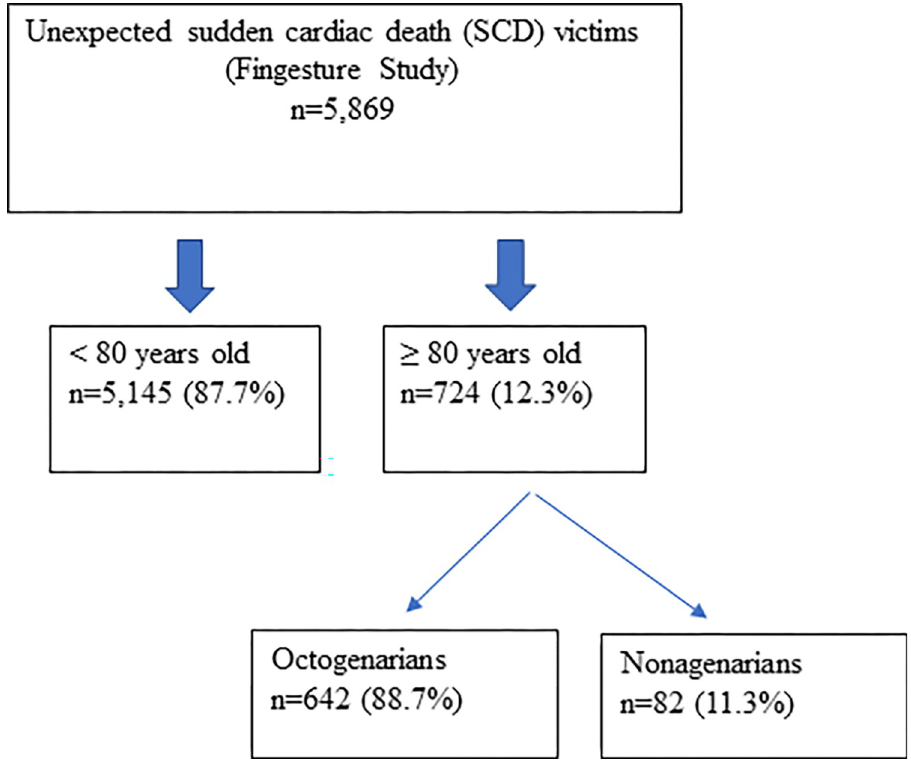
Fig 1. Flow chart of the study population. The data was obtained from the large prospective Fingesture study (Finnish Genetic Study of Arrhythmic Events), which consists of a consecutive series of 5,869 victims of unexpected sudden cardiac death (SCD) in Northern Finland. Medico-legal autopsy is mandatory in cases of unexpected sudden death in Finland. Octogenarians = from 80 to 89 years old. Nonagenarians = from 90 to 99 years old.